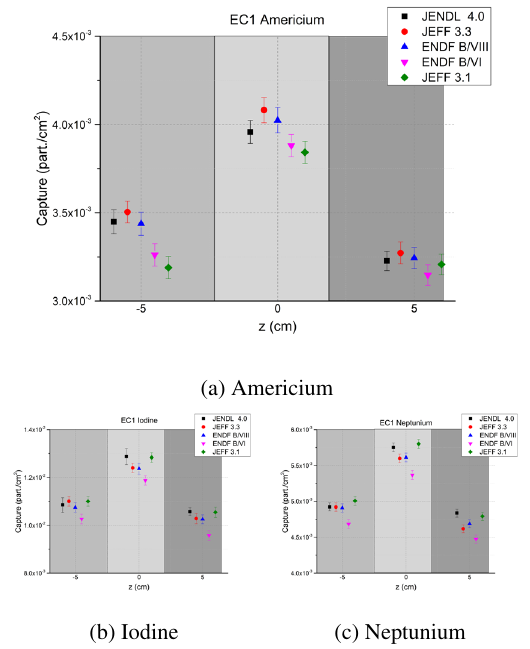
Figure 6: Neutron capture reaction rates